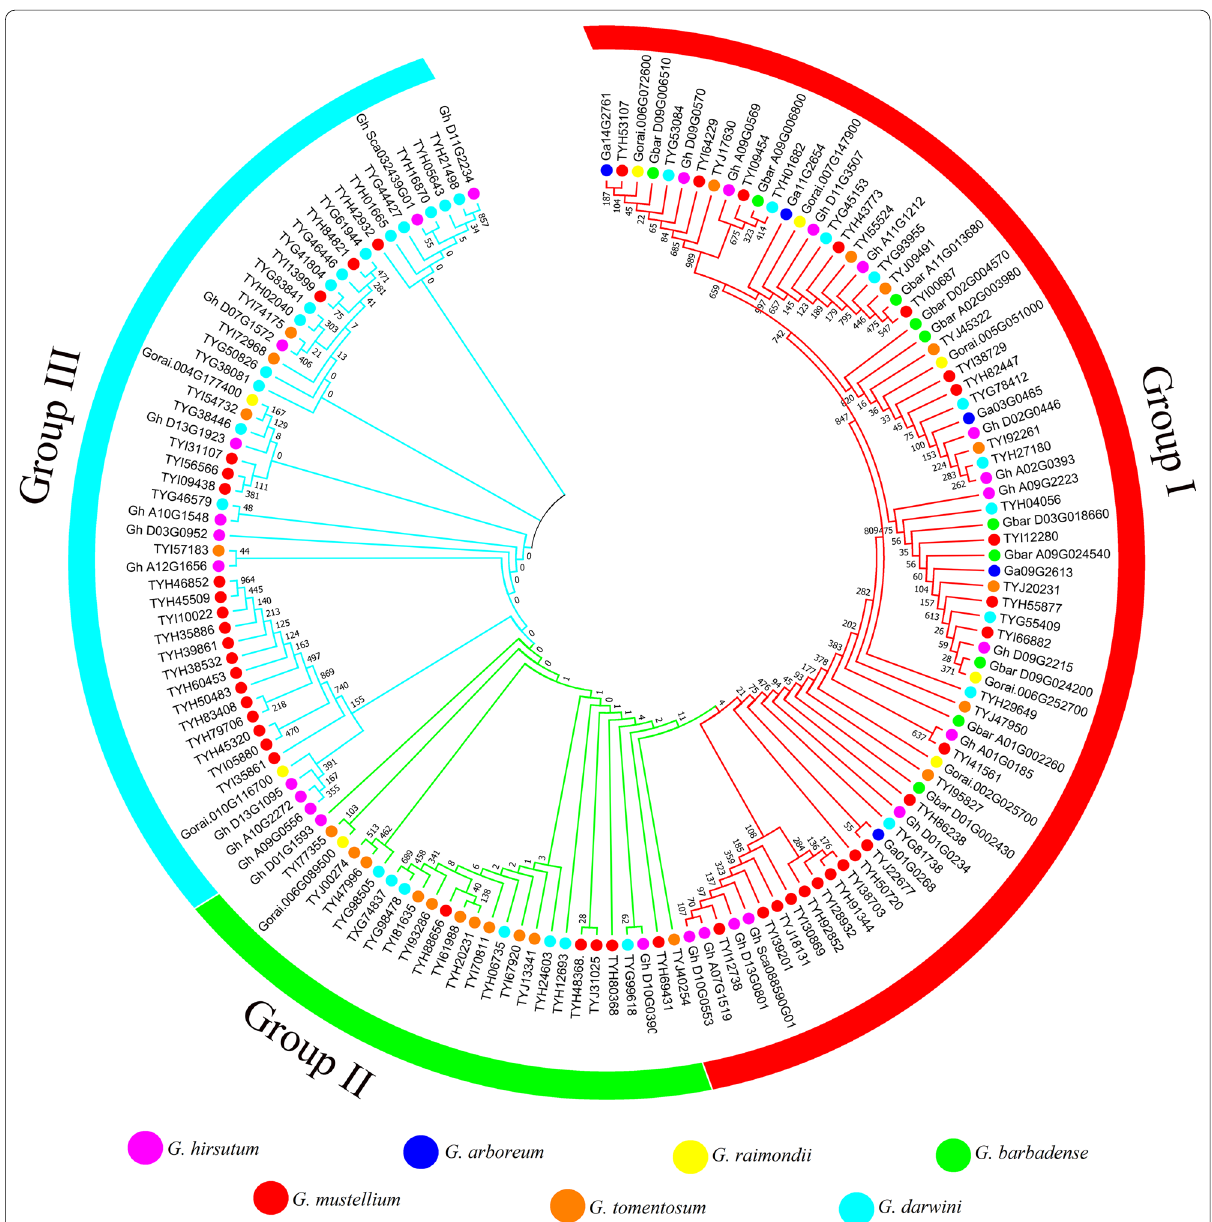
Fig. 1 Phylogenetic tree analysis of RPL14 proteins in G. hirsutum , G. raimondii , G. arboreum , G. tomentosum , G. mustelinum , G. barbadense , and G.